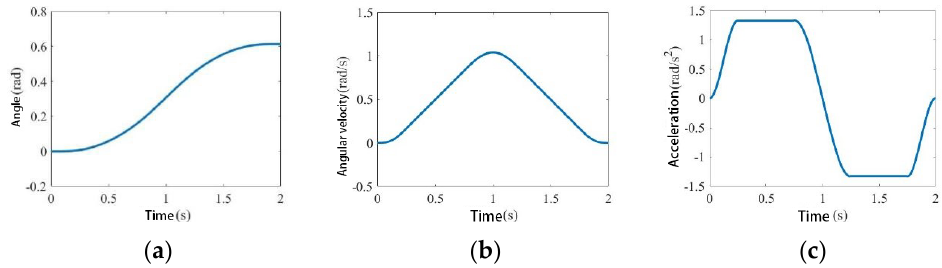
Figure 14. Angle, angular velocity and angular acceleration of joint 1.